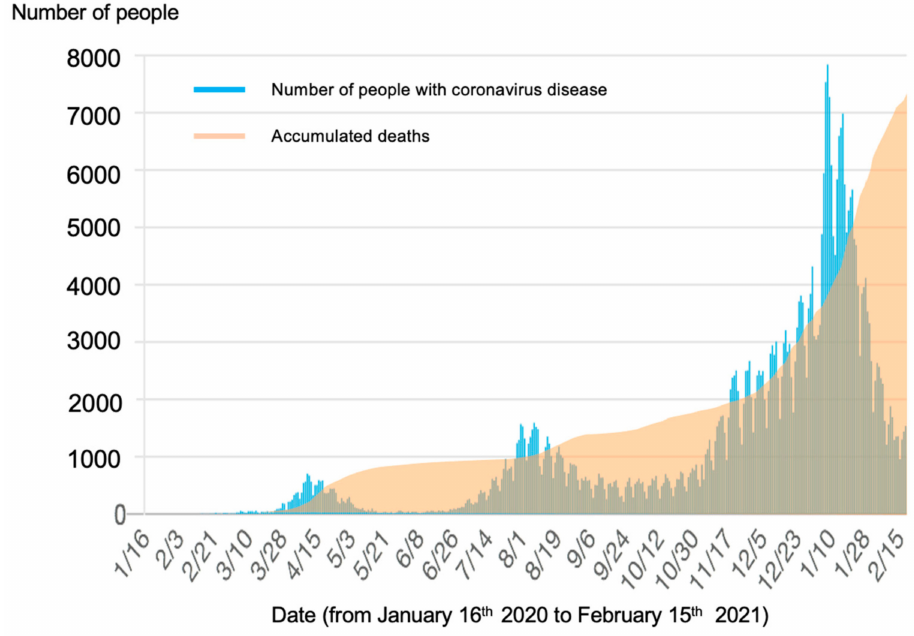
Figure 1. Changes in the number of people with coronavirus disease and accumulated deaths in